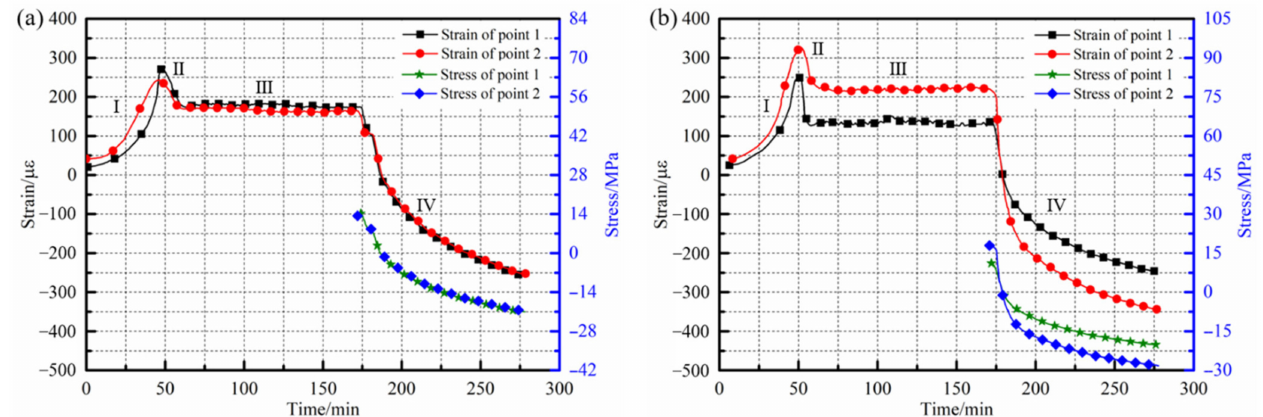
Figure 18. Strain/stress curves of composite laminates during microwave heating process: ( a ) tradi- tional heating condition; ( b ) regulating device